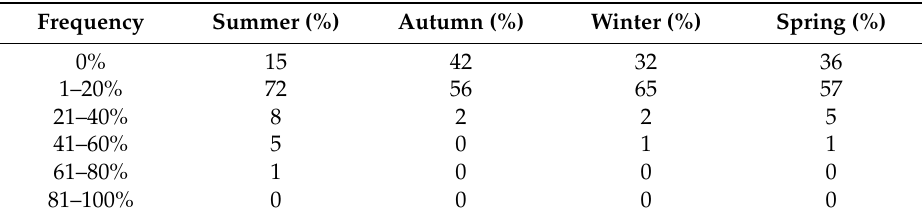
Table 3. Cloud cover percentage of Tibetan area for different ranges of frequency of four seasons during 2001–2015.